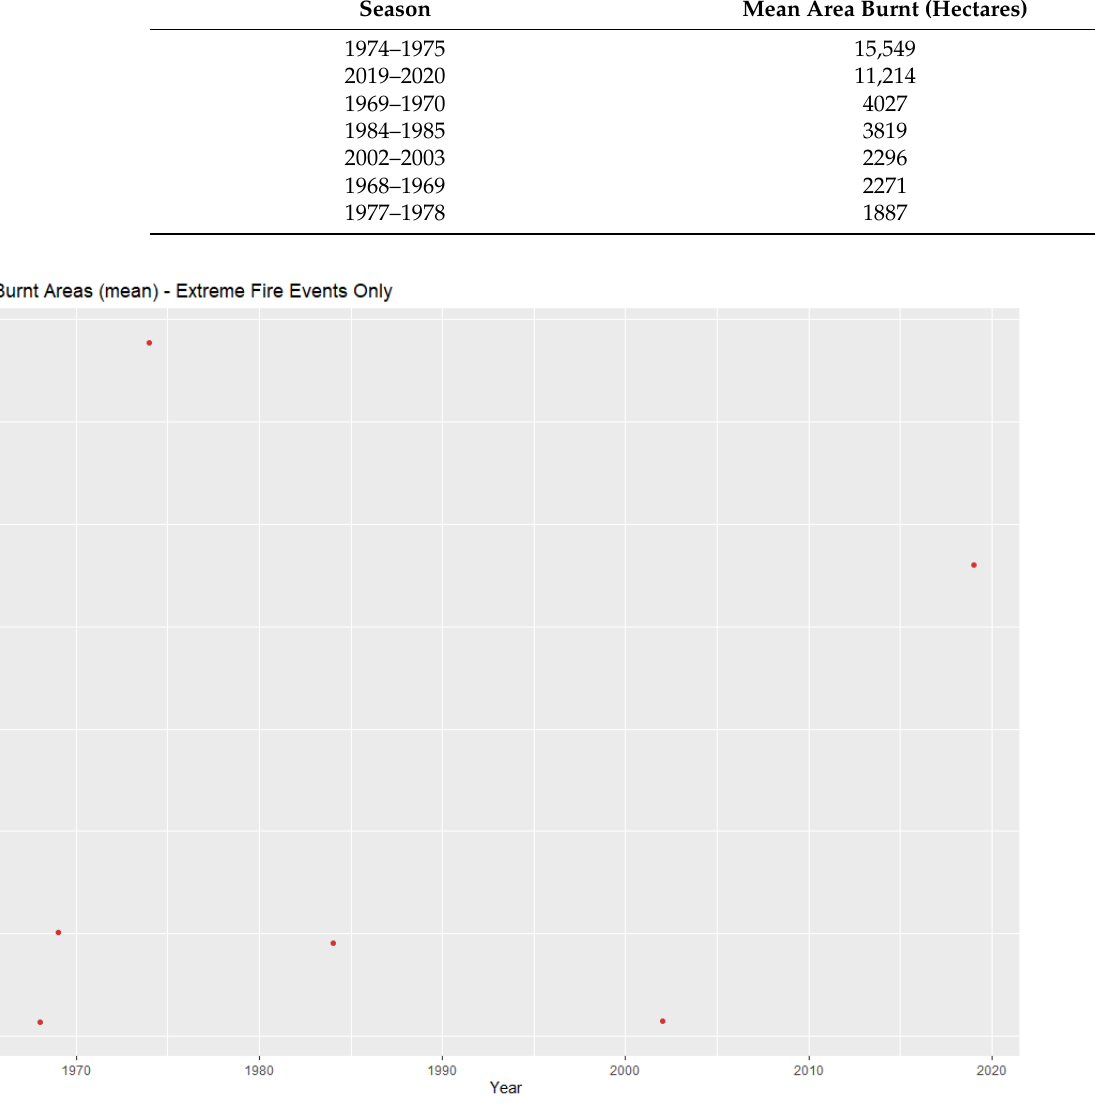
Figure 12. Correlation between prescribed burns and bushfires.